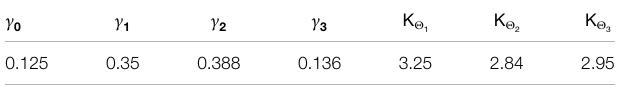
TABLE 1 | Optimized values of characteristic